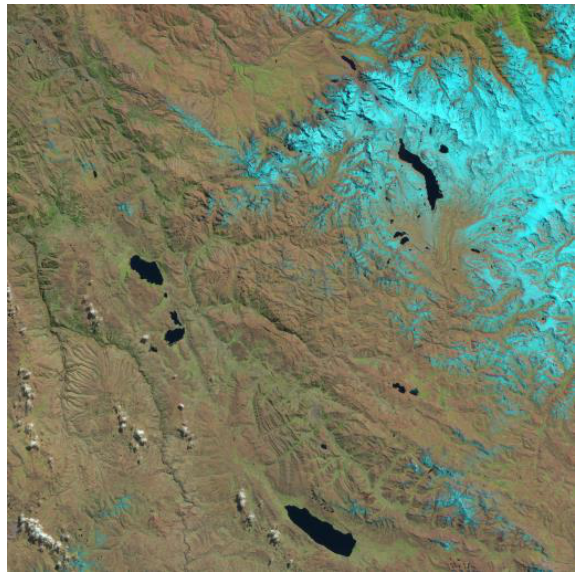
Figure 1. Figure placement and numbering To compute the thematic accuracy of both distributed implementations, K-Means and the EM algorithms, we used a scaled version at 40% of the dataset (original image and its binary mask). For that purpose, we divided the dataset into training and generalization samples, we randomly selected 10% of the pixels in the ground truth image (for each class) as the training data, and the remaining 90% of pixels were considered as the generalization data for assessing the thematic accuracy of the clustering models created with the previously training data, as presented in Figure 3.